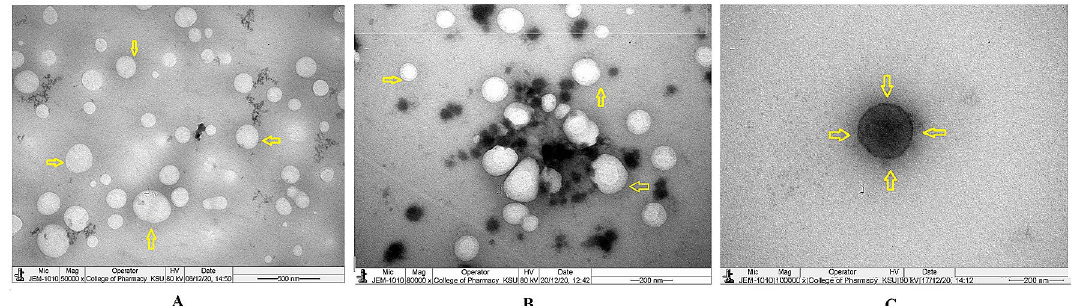
Figure 8. Transmission electron microscope study. ( A ) Morphology of lyophilized mAbCCNP under ×50,000 magnification. ( B ) Morphology of lyophilized mAbCCNP under ×80,000 magnification. ( C ) Morphology of lyophilized mAbCCNP under ×100,000 magnification. The yellow colour aero marks of all the three photographs indicating clear zone around the nanoparticle that represents rituximab attachment on